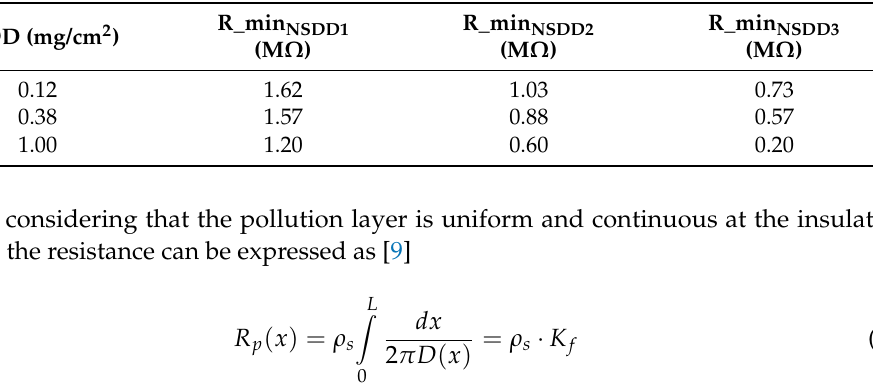
Table 4. Average minimum resistance corresponding to each NSDD for the used ESDD.